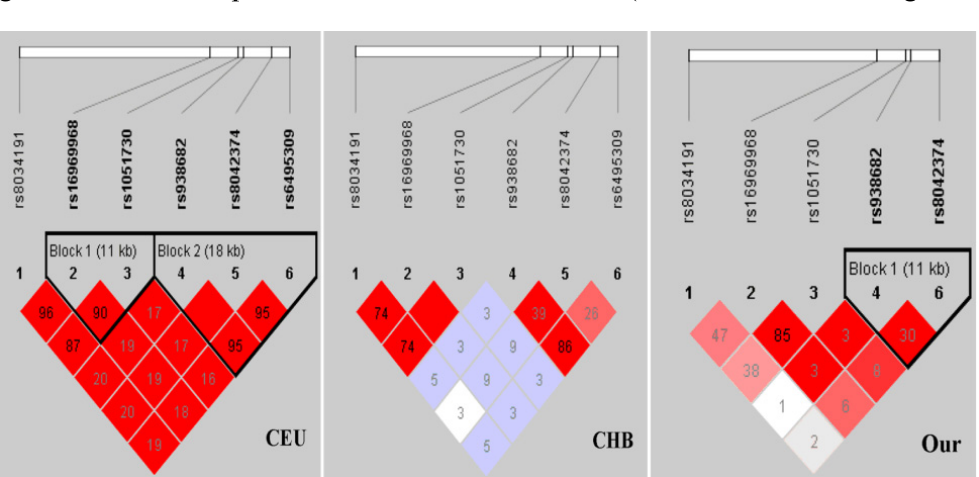
Figure 2. Linkage disequilibrium (LD) patterns of five SNPs in 15q25.1 among various populations. Numbers inside the boxes represent r 2 values for LD. Colors indicate the strength of LD between pair-wise combinations of SNPs (white, low LD; red, high